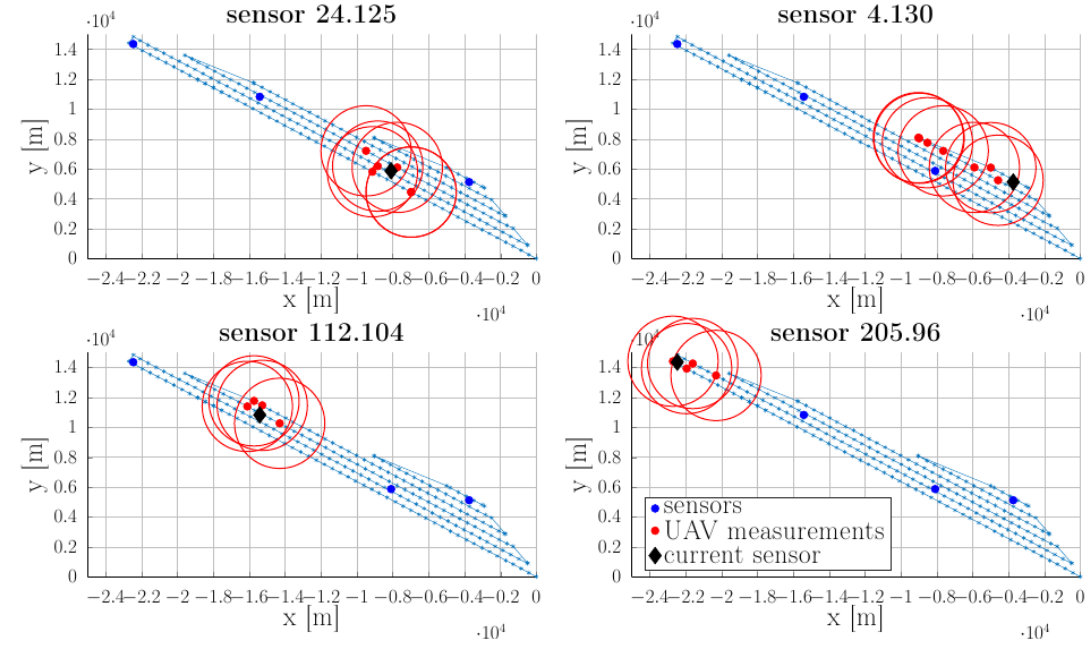
Figure 14. Sensor nodes response positions.